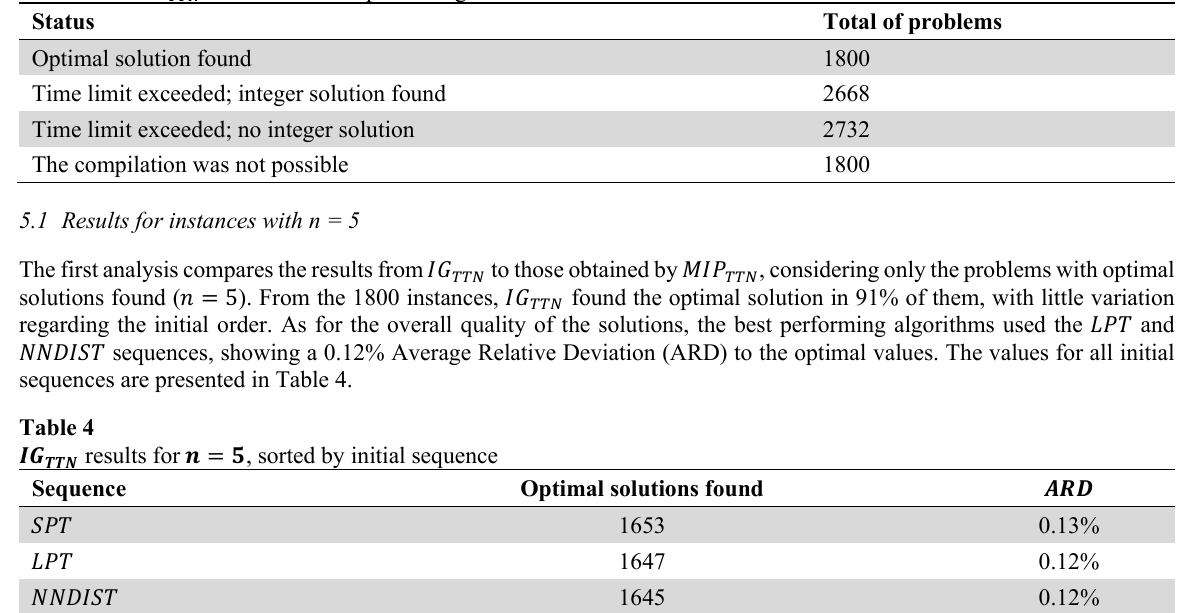
Average computational time (in 𝒎𝒔 ) for each method to solve the small instances 𝒎 𝑰𝑮